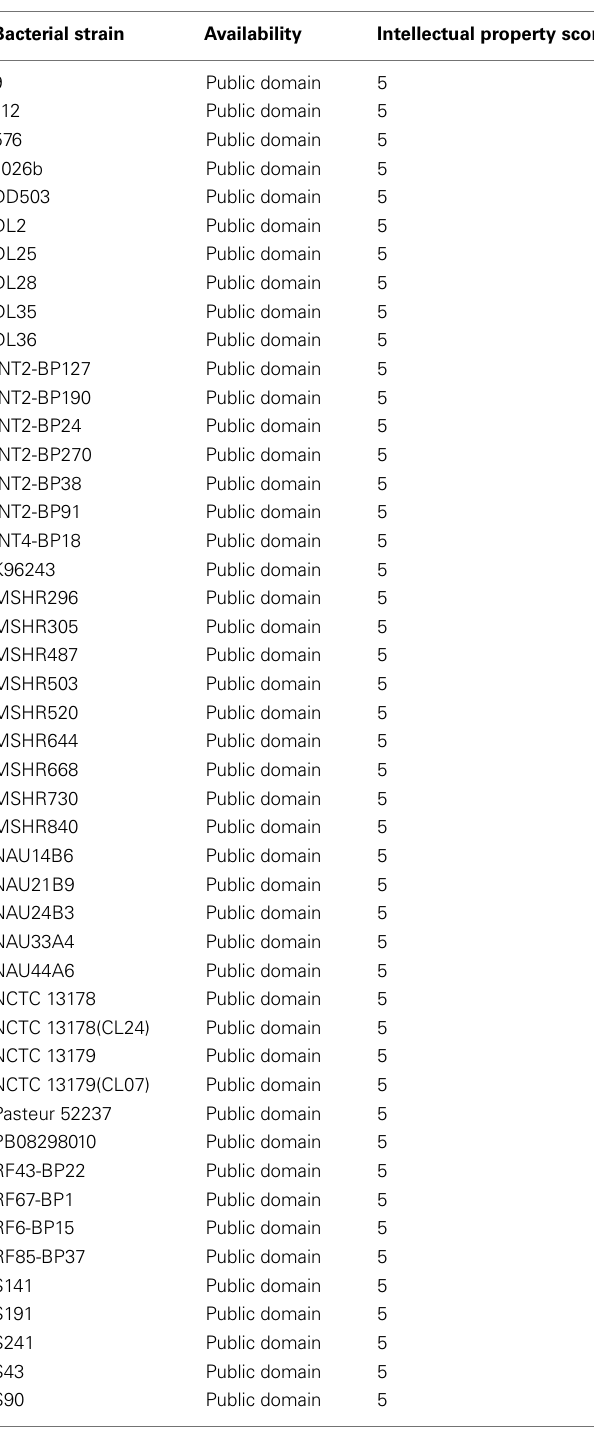
Table 5 | Burkholderia pseudomallei strains available in the public